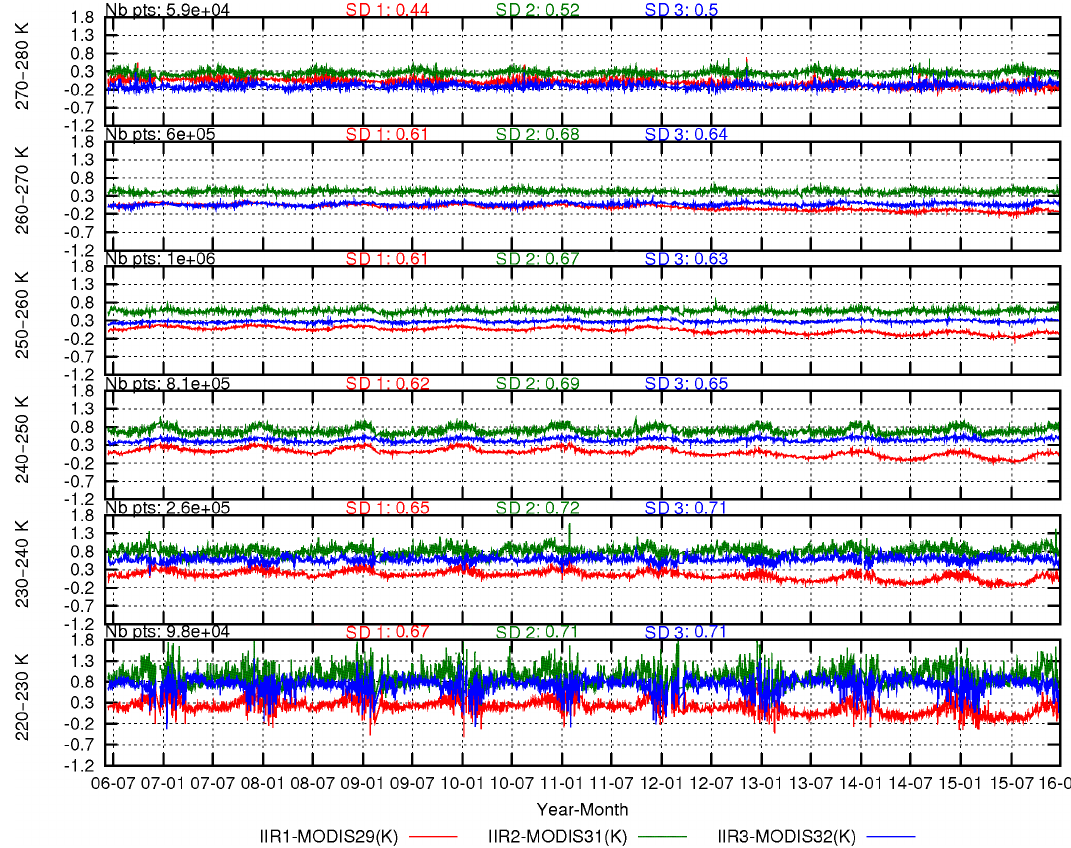
Figure 6. Time series ( x axis: year-month) of daily averaged (day and night combined) IIR–MODIS brightness temperature differences ( y -axis units: Kelvin) for the three pairs of companion channels (red: IIR1–MODIS29, green: IIR2–MODIS31, blue: IIR3–MODIS32) over ocean at 82–60 ◦ S. Each panel is for a given range in brightness temperature from 270–280K (top) down to 220–230K (bottom). Added at the top of each panel are the mean number of points per day (Nb pts) and the mean standard deviation per day for each of the three pairs (see Table